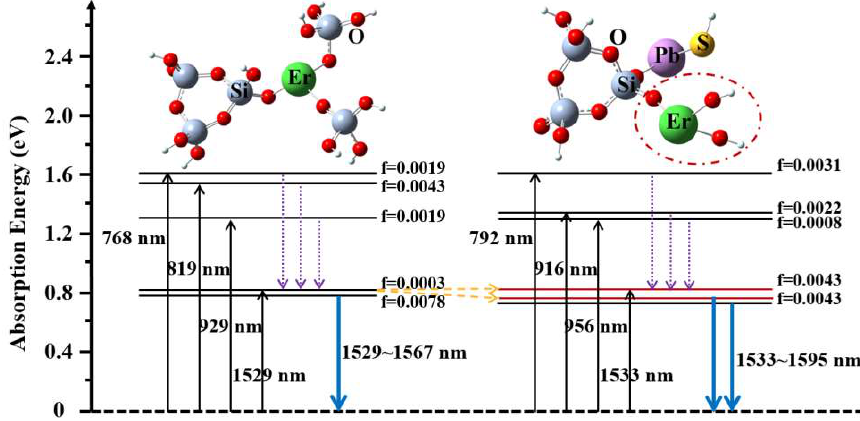
Figure 5. Energy level diagrams of Er-3MR and PbS/Er-3MR local structural models.